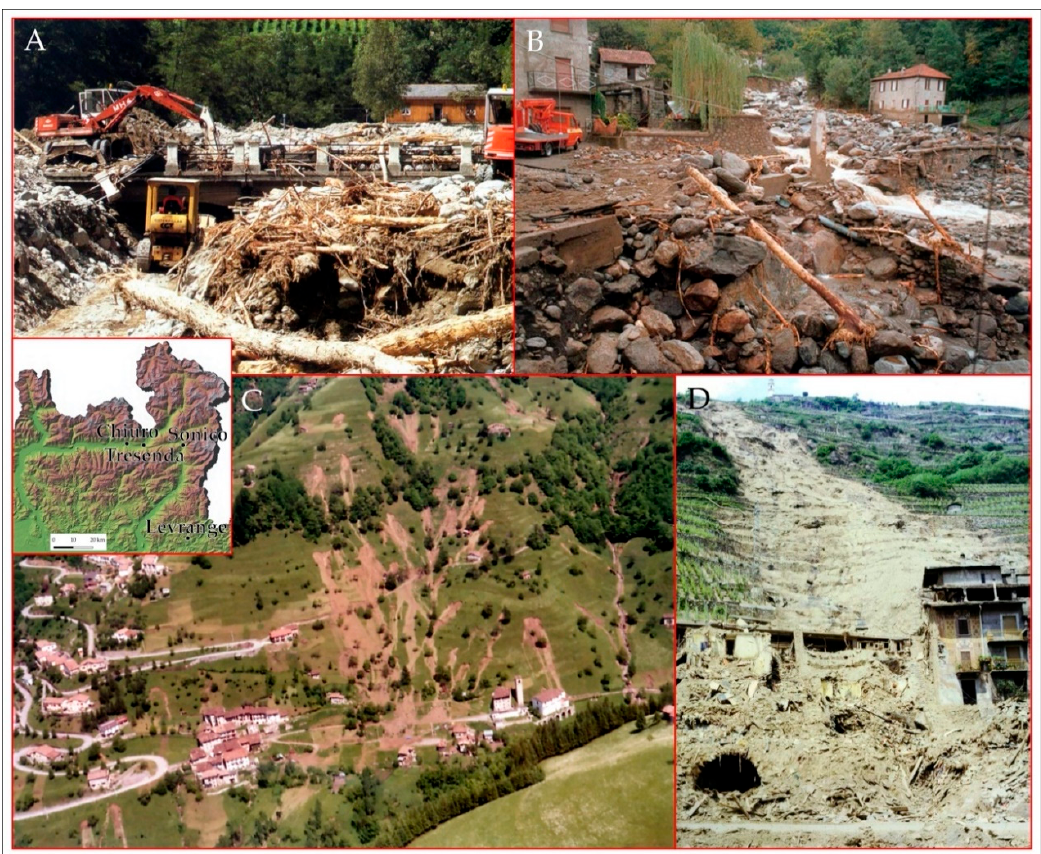
Figure 5. Example pf shallow landslides triggered by intense rainfall in the alpine provinces of Lombardy Region: ( A ) view of a bridge totally blocked and overflooded by the exceptional mud-debris flow that occurred at Chiuro, Sondrio Province, on 19 July 1987; ( B ) view of the debris flow that occurred at Sonico, Brescia Province, on 26 September 1987, that destroyed some buildings and one bridge; ( C ) view of widespread soil slips that occurred at Levrange, Brescia Province, on 26 May 1981; ( D ) view of the soil slips triggered on a terraced slope at Tresenda, Sondrio Province, on 22 May 1983, causing severe damage to some buildings.